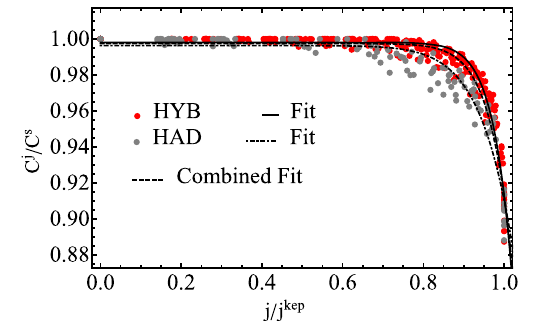
Fig. 3 Plotof C s / C k asafunctionof j / j k forNSsandHSsconstructed from 18 HYB EoS are shown in the figure. Gray dots represent the NSs, and the HSs are red